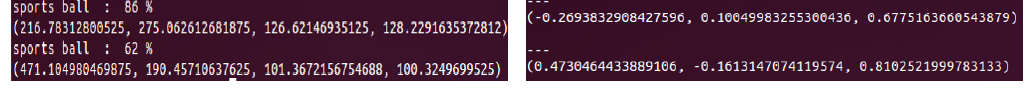
Figure 9. Coordinate information of tennis